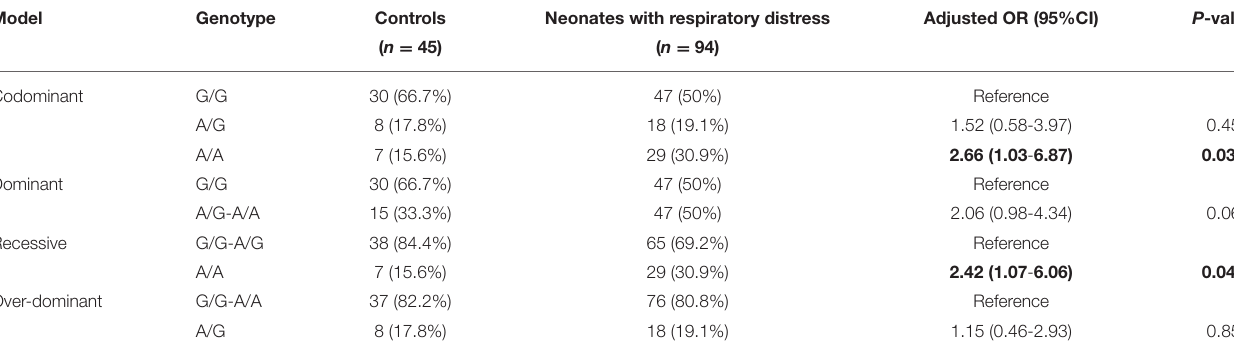
TABLE 3 | Genetic association models for neonatal respiratory distress risk assessment.